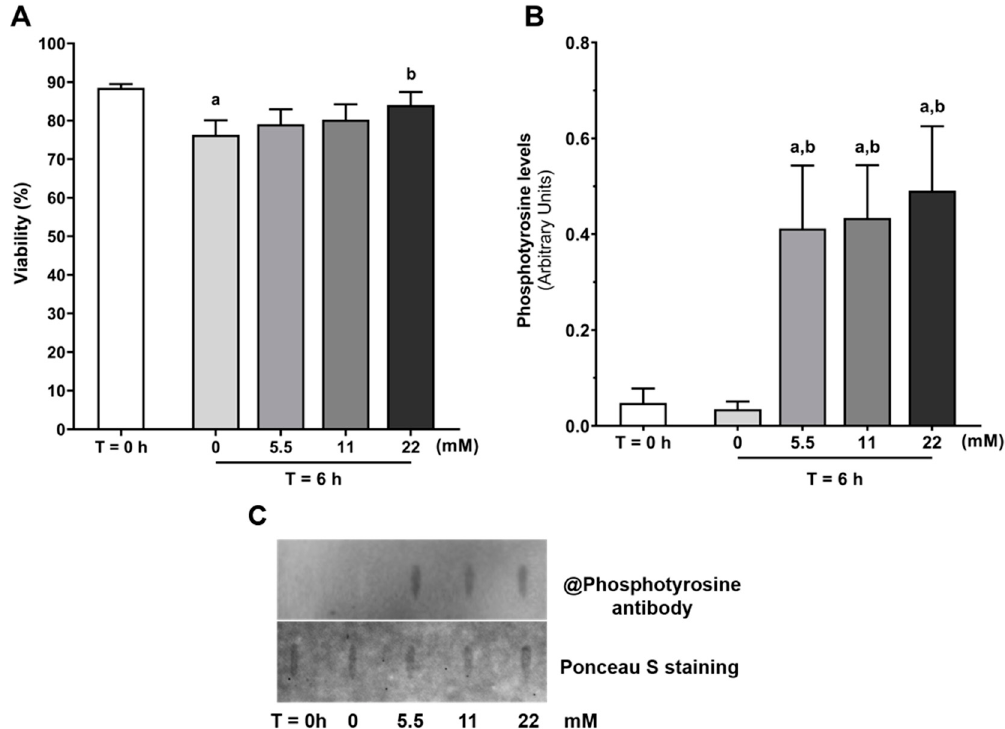
Figure 1. Evaluation of human spermatozoa viability as determined by eosin-nigrosin staining ( A ) and mean tyrosine residues phosphorylation levels ( B ) at baseline (T = 0 h) and without or with glucose (0, 5.5, 11 and 22 mM) stimuli for 6 h in capacitation conditions. ( C ) Representative slot blot membrane. Results are expressed as mean ± SEM (( A ) n = 15 for each condition, ( B ) n = 6 for each condition). Significantly different results are expressed as: ( a ) Relative to T = 0 h group; ( b ) Relative to 0 mM glucose group (T = 6 h).